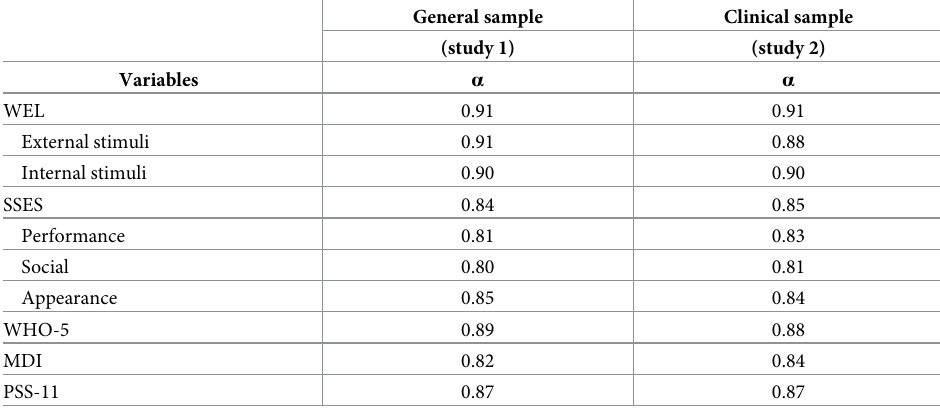
Table 1. Cronbach’s alpha coefficient of the scales used in studies 1 and